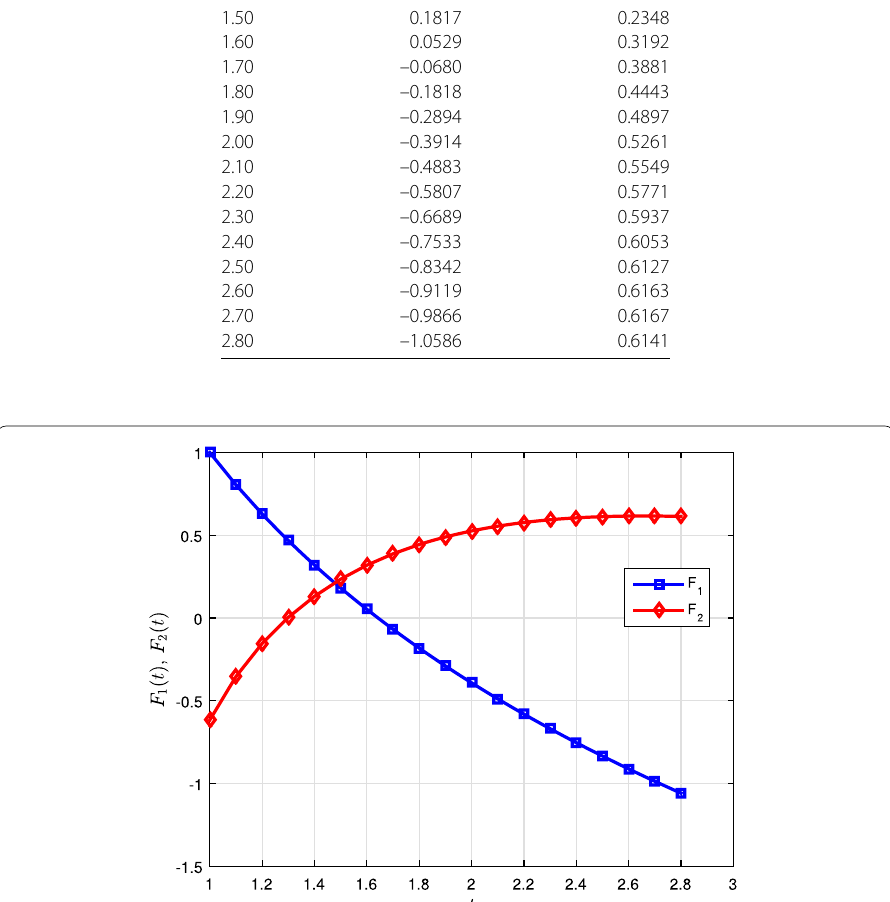
Figure 1 Graphical representation of F 1 ( t ) and F 2 ( t ) for t ∈